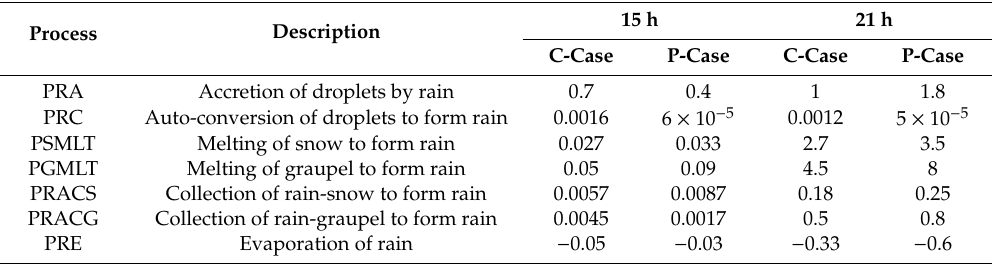
Table 1. Source-sink terms of rain (after Morrison and Pinto [76]) and maximum conversion rates in